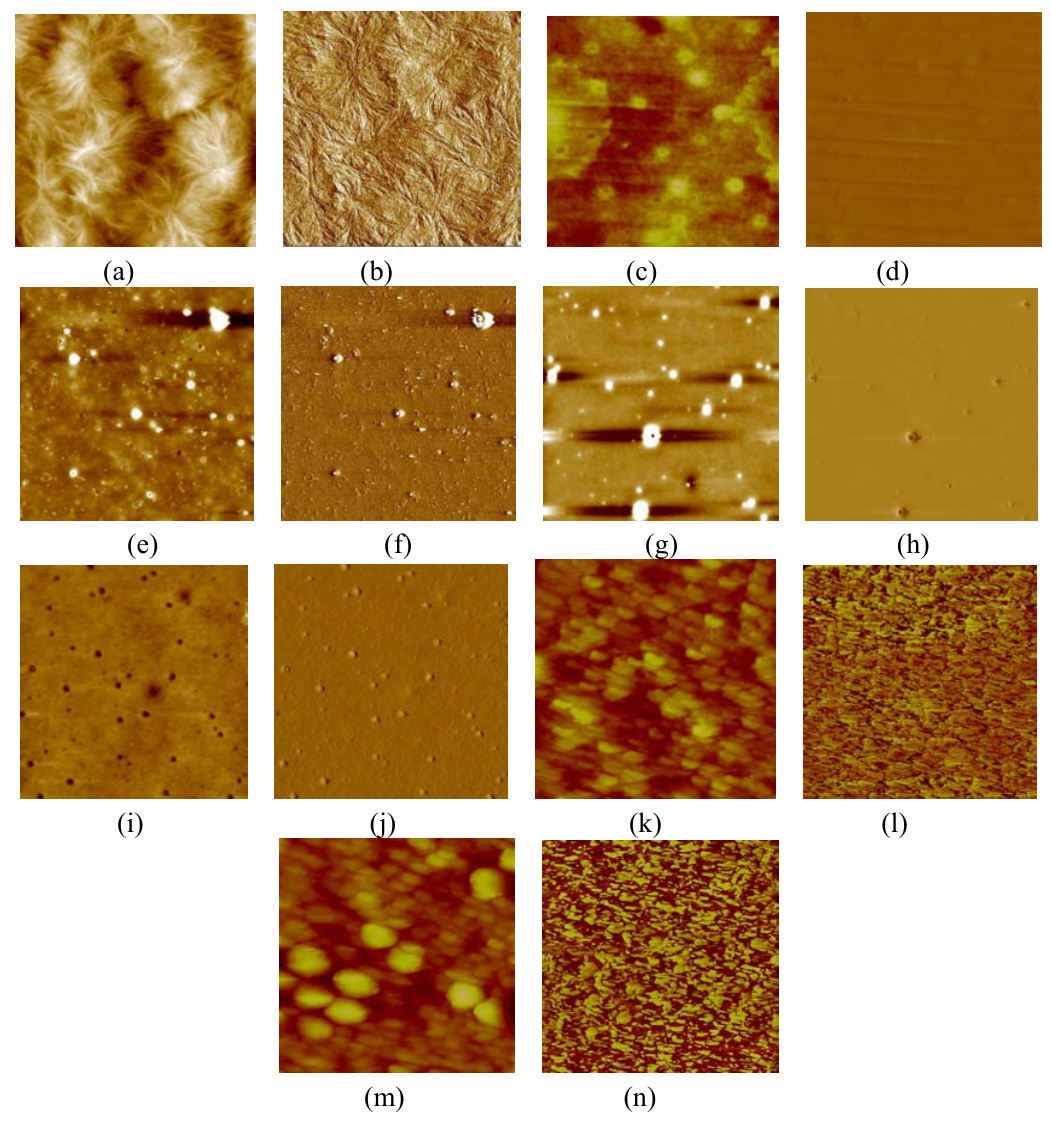
Figure 1. AFM study on SB-PLA non-oriented film (a in topology and b in phase mode), CS-PLA non-oriented film (c in topology and d in phase mode), CS-PLA oriented film (e in topology and f in phase mode),on SB-PLA oriented film (g in topology and h in phase mode), CS-PLA oriented film (i in topology and j in phase mode), on DNA (k in topology and l in phase mode) and on DNA-CS- PLA (m in topology and n in phase mode). Scanning scopes: a. and b. 5 µm; c. and d. 5 µm; e. and f. 25 µm; g. and h. 25 µm; i. and j. 2 µm; k. and l. 1 µm; m. and n. 1